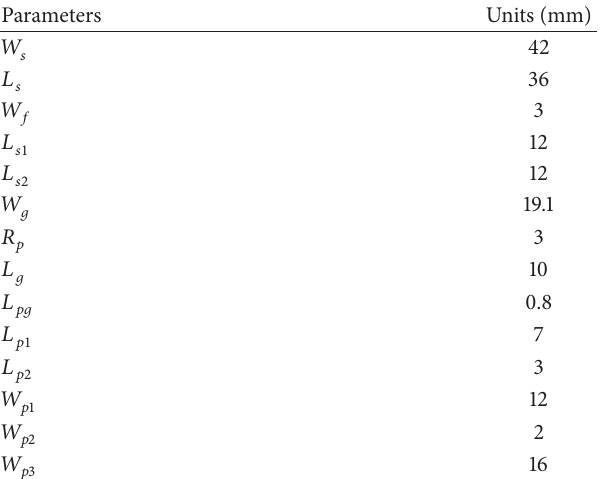
Table 1: Design parameters of the proposed defected substrate CPW-fed wideband